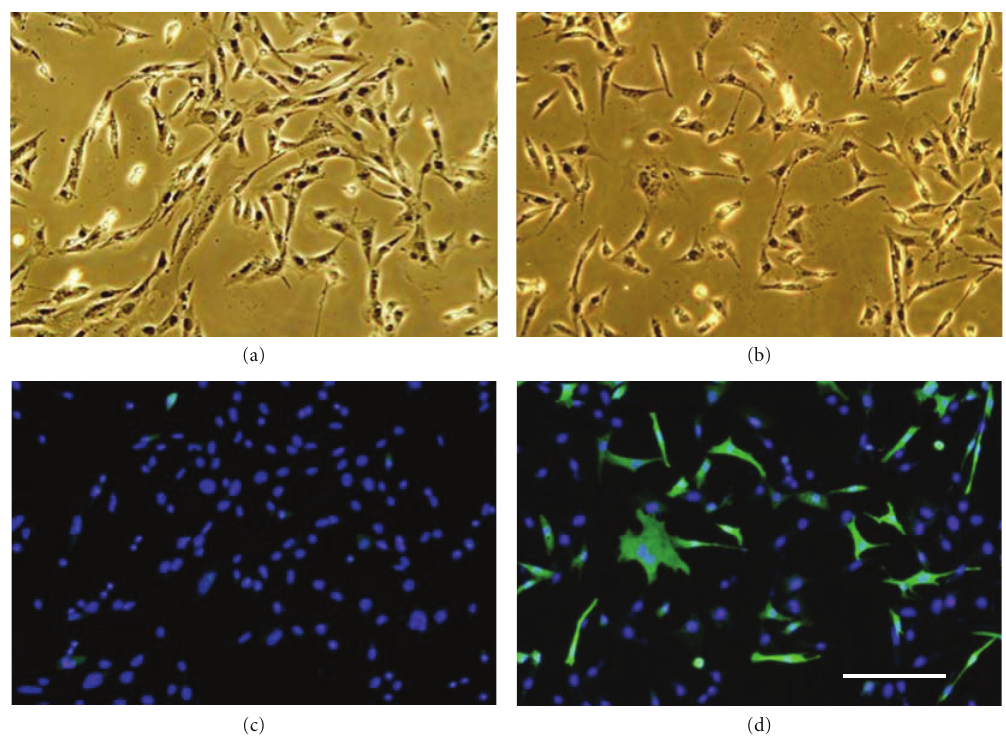
Figure 6: Behavior of C2C12 cells (myoblasts) transfected with the ha/mzyg1 fusion gene. C2C12 cells were transfected with the ha gene (control; a, c) or ha/mzyg1 fusion gene (HA/ZYG1; b, d), fixed with 4% paraformaldehyde and stained by antibodies and DAPI according to the methods described in Section 2. Phase-contrast micrographs on the upper sides represent the same field as the merged images of FITC and DAPI on the lower sides ((a) and (c), (b) and (d)). C2C12 cells expressing the HA/ZYG1 fusion protein stained with the anti-HA antibody and then FITC-conjugated anti-mouse secondary antibody are detected as the green-colored cells under a fluorescence microscope though a considerable number of cells are intermingled as untransfected ones in the population (d). Nuclei stained with DAPI are shown as purple color by UV-excitation (c and d). The transfection rate with the ha/mzyg1 gene was 36.8 ± 8%. The expression of HA protein in control cells was scarcely detected (c). Bar: 100 μ